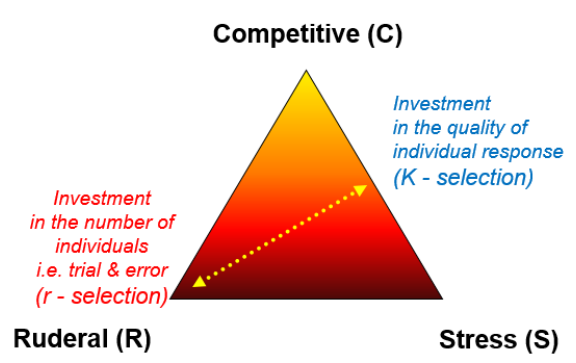
Figure 2. Illustration of the Philip Grime’s CSR